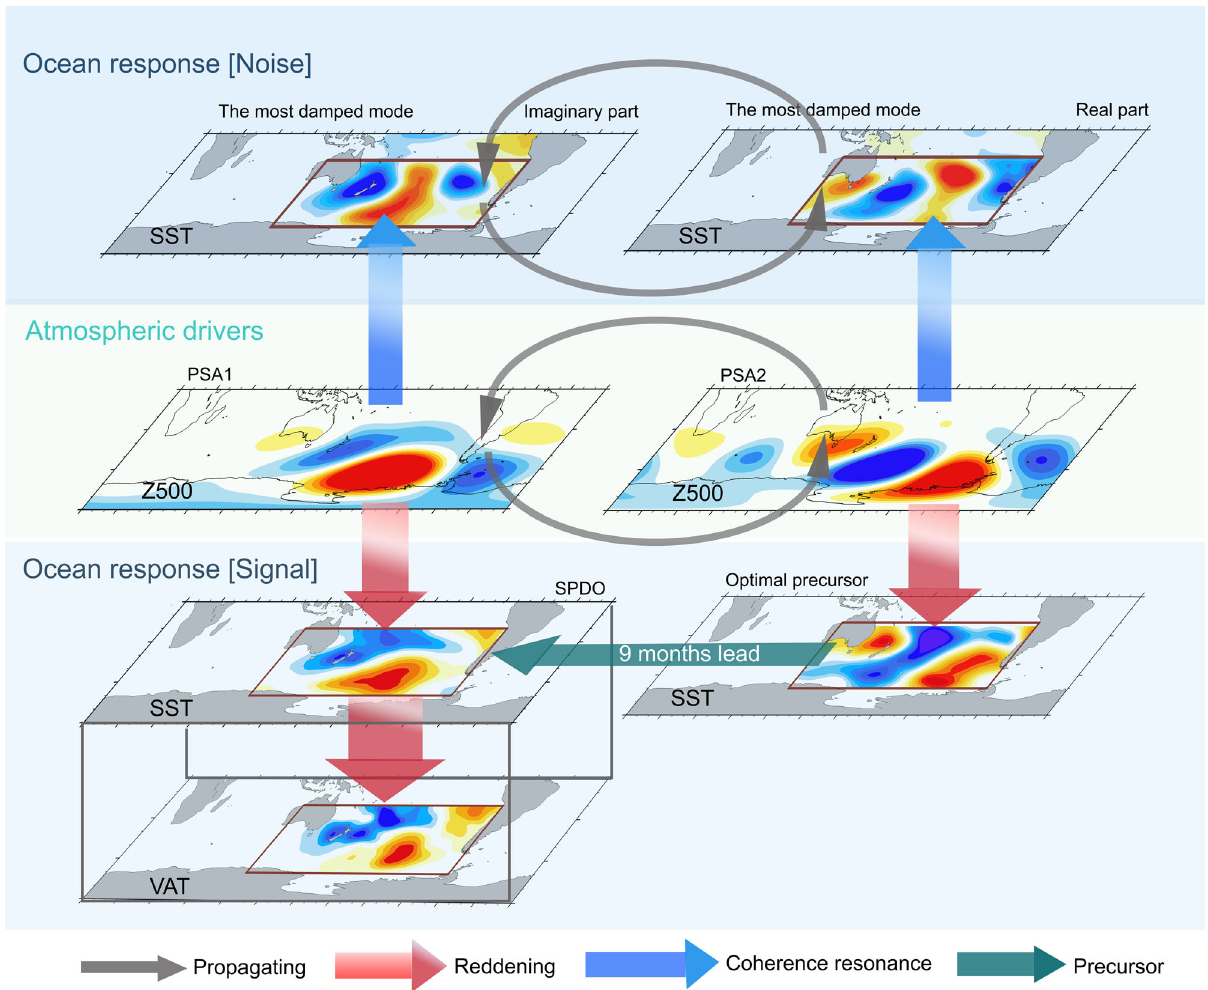
Fig. 4 Schematic of the paradigm for South Paci fi c Ocean variability and predictability. The top panels are the same as shown in Fig. 2a and b indicating the fastest damped mode pair. The middle panels are the second and third modes of the monthly Z500 anomalies (NCEP-NCAR) in the southern hemisphere. The left panels of the bottom layer are the leading EOF modes of the monthly SST anomalies and VAT anomalies in the South Paci fi c Ocean, respectively. The right panel of the bottom layer is the same as shown in Fig. 3c indicating the optimal precursor of the SPDO (illustrated by the green arrow). Red arrows indicate reddening processes. Blue arrows indicate coherence resonances. Grey arrows indicate the propagating features of the corresponding